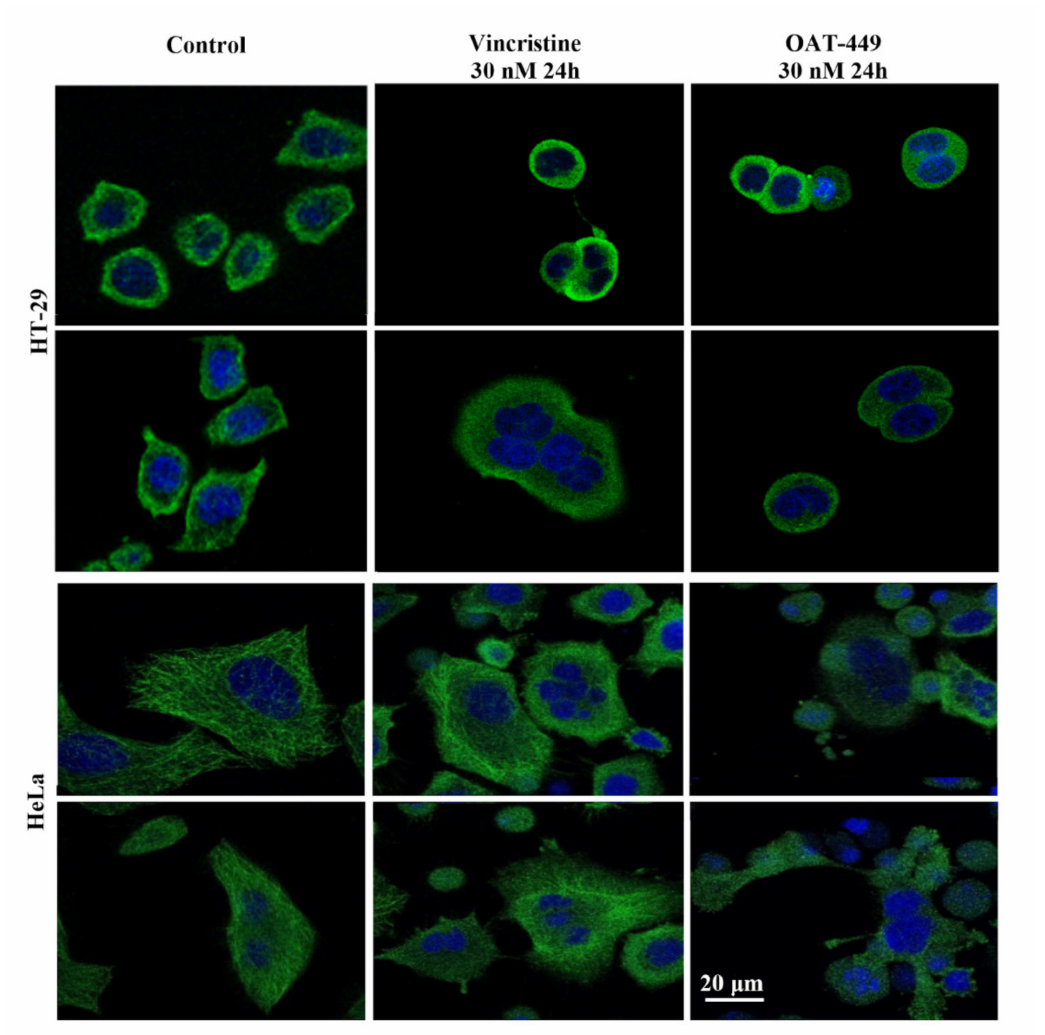
Figure 5. Both OAT-449 and vincristine cause mitotic defects, multi-nucleation, aneuploidy and polyploidy through the blocking of the tubulin polymerization and induces G2 / M phase cell cycle arrest. Cancer cells HT-29 and HeLa were grown on coverslips and treated with control culture medium, 30 nM OAT-449 or vincristine for 24 h, fixed with 2% formaldehyde, stained with DAPI and Alexa Fluor 488-conjugated anti-tubulin antibody (green fluorescence) and examined using confocal microscopy. The images are representative of at least 3 independent